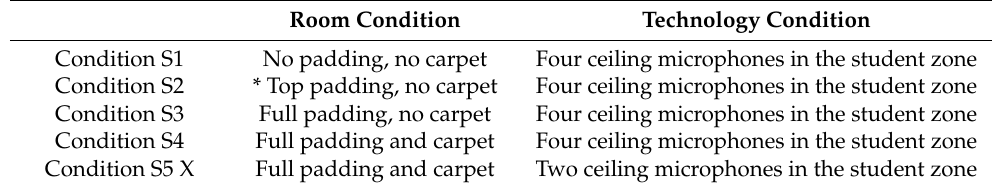
Table 2. Students’ Interactions